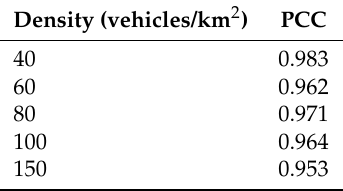
Figure 7. Scatterplot of sociocentric vs. egocentric betweenness for each vehicle traffic density. Table 4. Pearson correlation coefficient (PCC) of egocentric and sociocentric